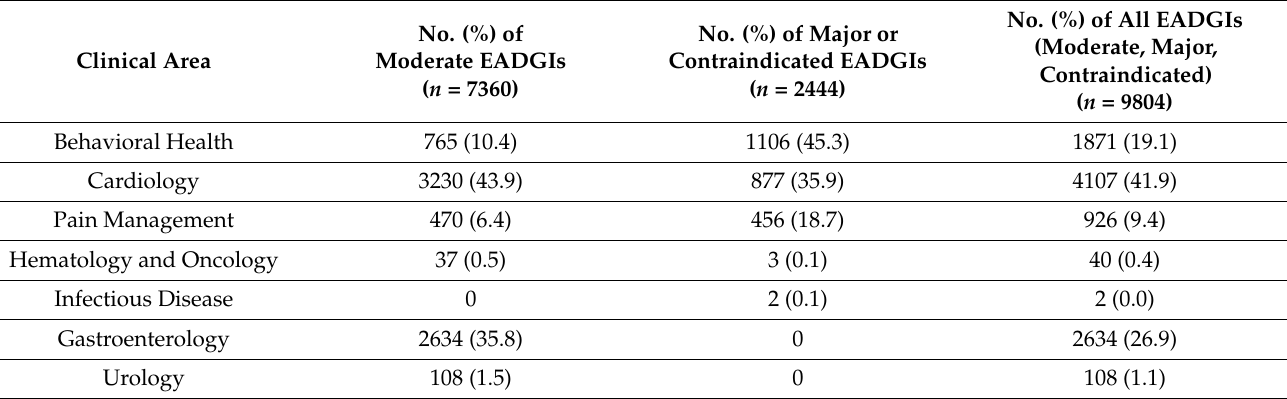
Table 3. EADGIs according to clinical area.